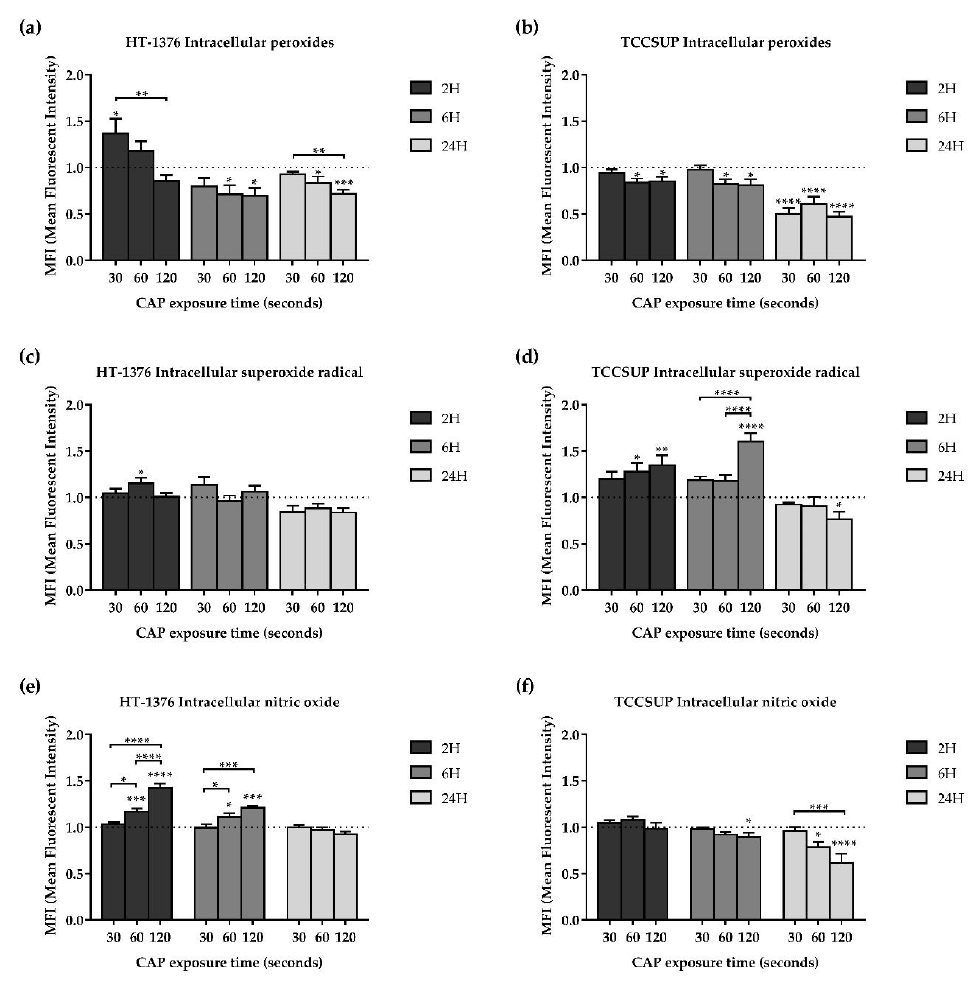
Figure 3. In both HT-1376 and TCCSUP cell lines, the intracellular content of peroxides ( a , b ) decreased and the superoxide radical ( c , d ) increased, while the nitric oxide increased in the HT-1376 cell line ( e ) and decreased in the TCCSUP cell line ( f ), depending on the exposure time and time after CAP treatment. Intracellular contents of peroxides (n ≥ 4 independent experiments in triplicate), superoxide radical (n ≥ 4 independent experiments in triplicate), and nitric oxide (n ≥ 4 independent experiments in triplicate) were evaluated by fluorescence using the probes DCFH 2 -DA, DHE, and DAF-FM Diacetate, respectively, 2, 6, and 24 h after CAP treatment. Results are expressed as the mean ± SEM of the mean fluorescence intensities (MFIs) normalized to control. Statistical differences between exposure times within 2 or 6 or 24 h after the CAP treatment are represented with “*” with horizontal bars and the differences between the exposure times and the control within 2 or 6 or 24 h after the CAP treatment are represented with “*” on top of the respective column, being p value reported as * p ≤ 0.05, ** p ≤ 0.01, *** p ≤ 0.001, **** p ≤ 0.0001.